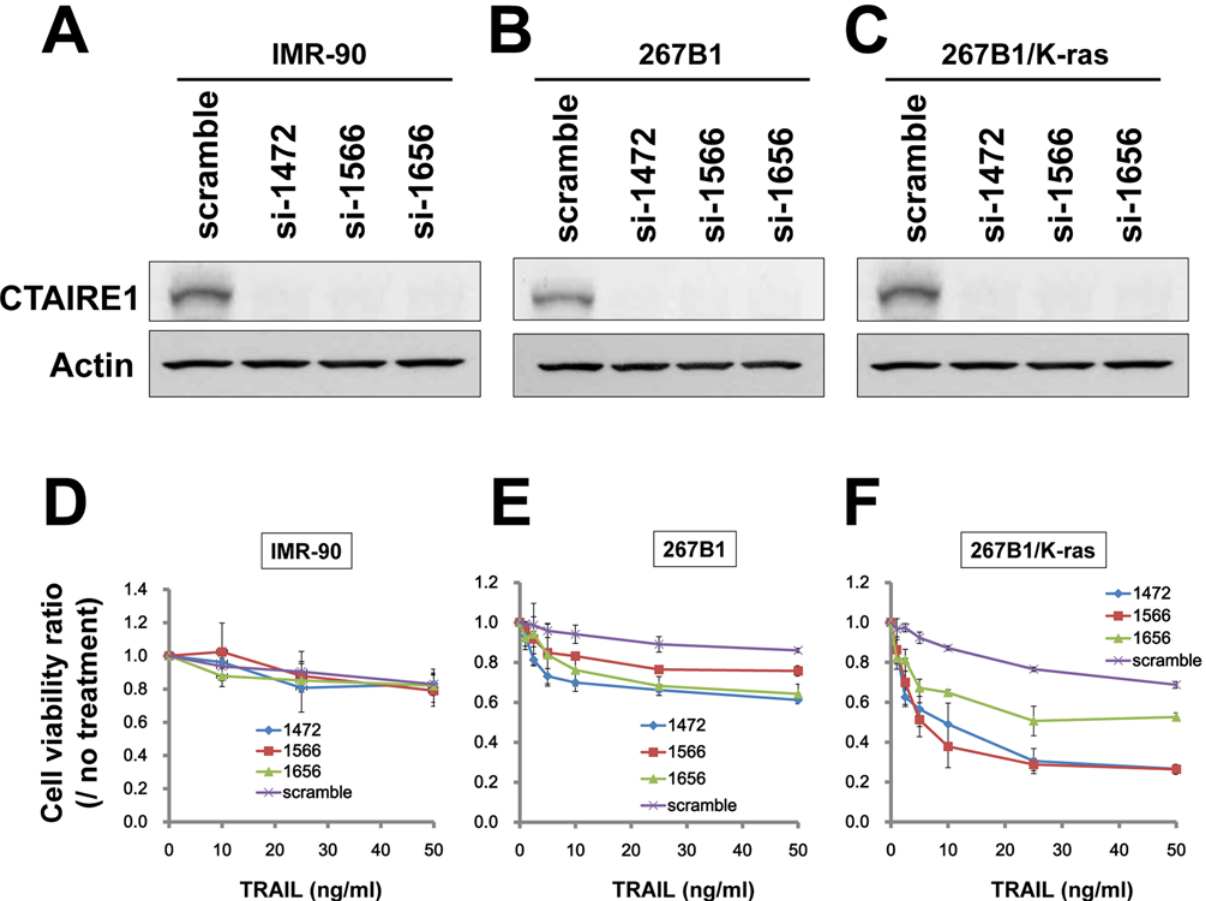
Fig 3. Transformed cells are preferentially sensitive to PCTAIRE1 knockdown-effect with TRAIL treatment. (A-C) Human diploid fibroblasts IMR-90 (A), 267B1 immortalized normal prostate epithelial cells (B), and K-ras transformed 267B1 (267B1/K-ras) cells (C) were transfected with scrambled RNA or three different siRNAs targeting PCTAIRE1 (siRNAs: si-1472, si-1566, si-1656). Lysates of cells 72 hours post-transfection were prepared and analyzed by immunoblotting using rabbit anti-PCTAIRE1 (top) or anti-beta-actin (bottom) antibodies. (D-F) IMR-90, 267B1 and 267B1/K-ras cells were transfected with siRNAs. After 48 hours, cells were stimulated with TRAIL at various concentrations as indicated. After 24 hours, cellular ATP levels were measured, and the data expressed as a ratio between cells cultured with and without TRAIL (mean ± SD; n =